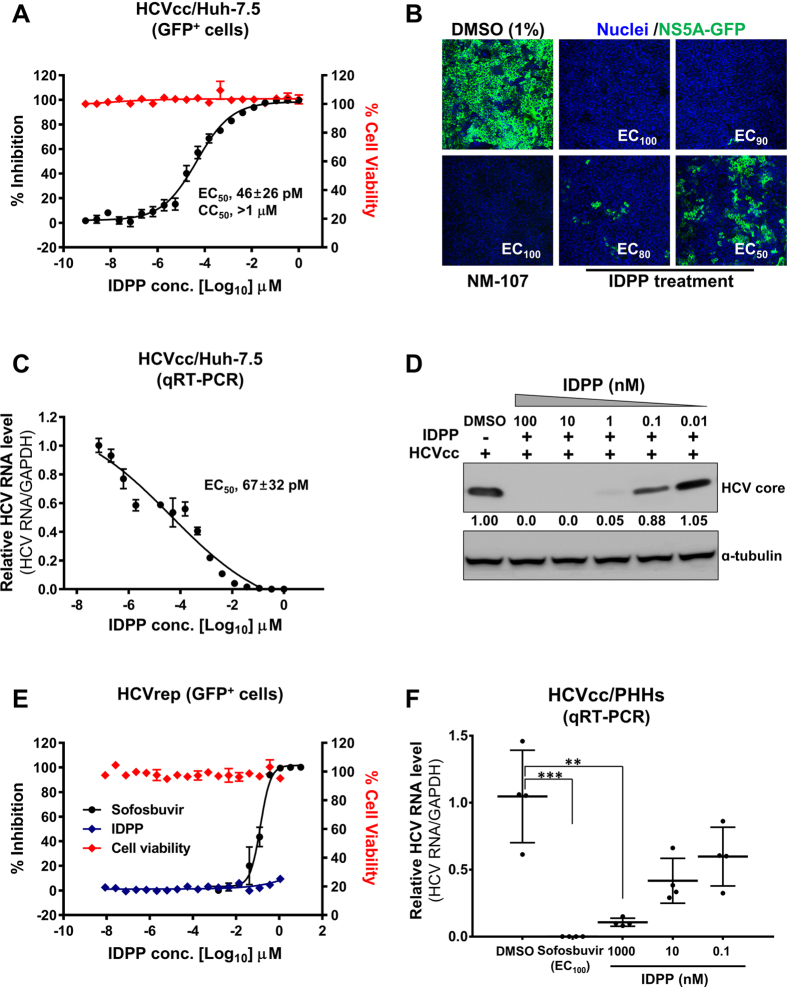
Anti-HCV activity of IDPP.(A) Anti-HCV activity in Huh-7.5 cells. Cells were pretreated with increasing concentrations of IDPP for 2 h followed by infection with HCVcc (JFH1) for 72 h in the presence of IDPP. Black squares and red squares indicate inhibition of HCV infection, and cell viability, respectively. The EC50 was determined by dose–response curve (DRC) analysis. Values represent the mean ± SD of five independent experiments in duplicate. (B) HCV replication and total cell number were assessed by determining the number of GFP-positive cells and blue nuclei for 3 days in the presence of inhibitors (IDPP and NM-107), respectively. Images were acquired by confocal microscopy at 200X. (C,D) DRC analysis was conducted as described above. (C) Intracellular HCV RNA levels were quantified by qRT-PCR and normalized to GAPDH mRNA (D) HCV core protein levels in lysates of infected cells were determined by Western blot analysis. (E) HCV subgenomic replicon cells were treated with IDPP and sofosbuvir. HCV replication was assessed by determining the number of NS5A-GFP-positive cells. (F) Evaluation of antiviral activity in PHHs. The inhibition of HCV infection was assessed by intracellular HCV RNA amounts quantified by qRT-PCR and normalized to GAPDH mRNA, ***p < 0.001 or **p < 0.01.